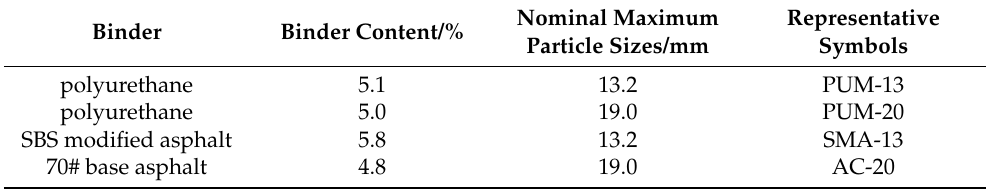
Table 2. The mixture composition of the four